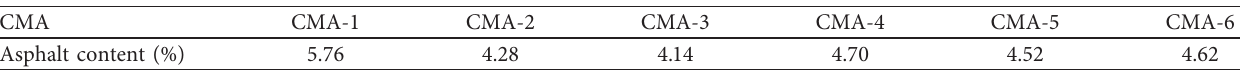
Figure 1: Aggregate gradation of the collected CMA patching materials. Table 1: Residual asphalt content in the collected CMA patching